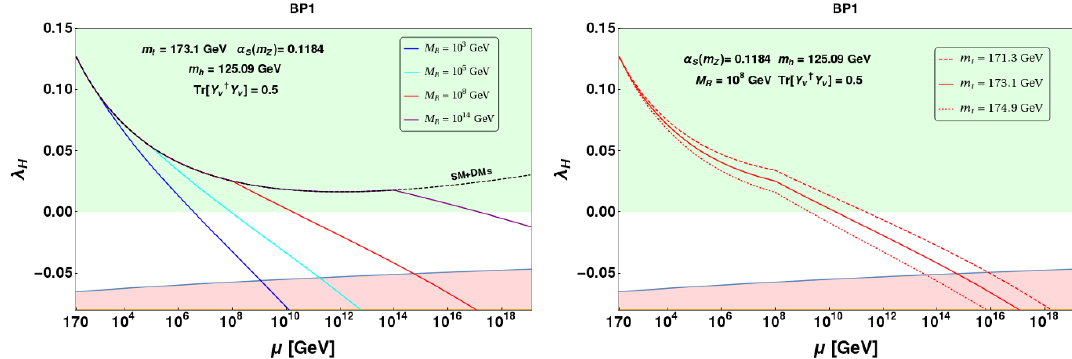
Figure 19 . RG running of (cid:21) H with energy scale for BP1. In left panel, we have shown the e(cid:11)ect of di(cid:11)erent right handed neutrinos masses, M R (indicated by di(cid:11)erent colours and mentioned in (cid:12)gure inset) for a (cid:12)xed top quark mass m t = 173 : 1 GeV. The black dotted line corresponds to the case when right handed neutrinos are absent in the scenario. In right panel, we choose a speci(cid:12)c M R = 10 8 GeV and consider top mass in 2 (cid:27) range: m t = 173 : 1 (cid:6) 0 : 9 GeV. Tr[ Y y constant in both plots.